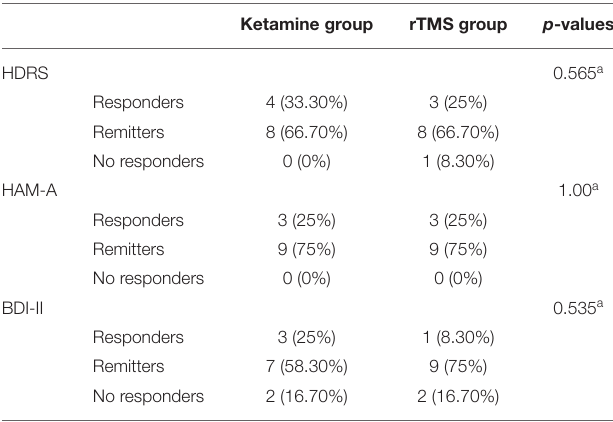
TABLE 2 | Responders and remitters, n (%).